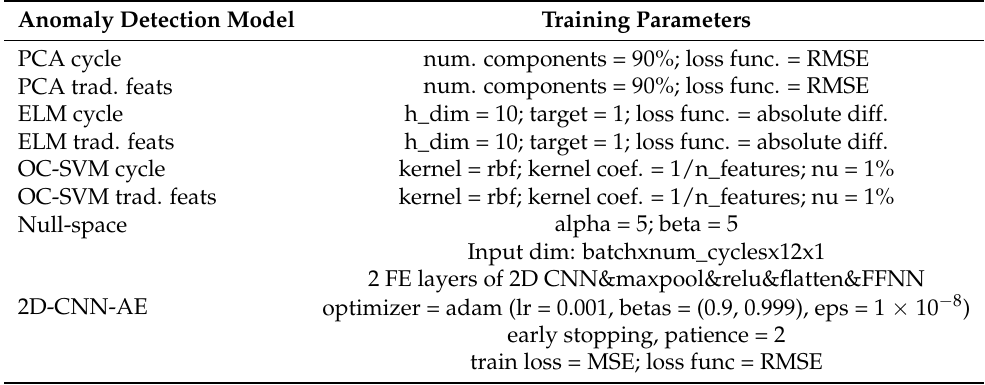
Figure 4. Architecture of 2D-CNN-AE and its parameters. Table 3. Parameters for training anomaly detection models. Cycle and trad. feats refer to the way anomaly detection models prepare and process the